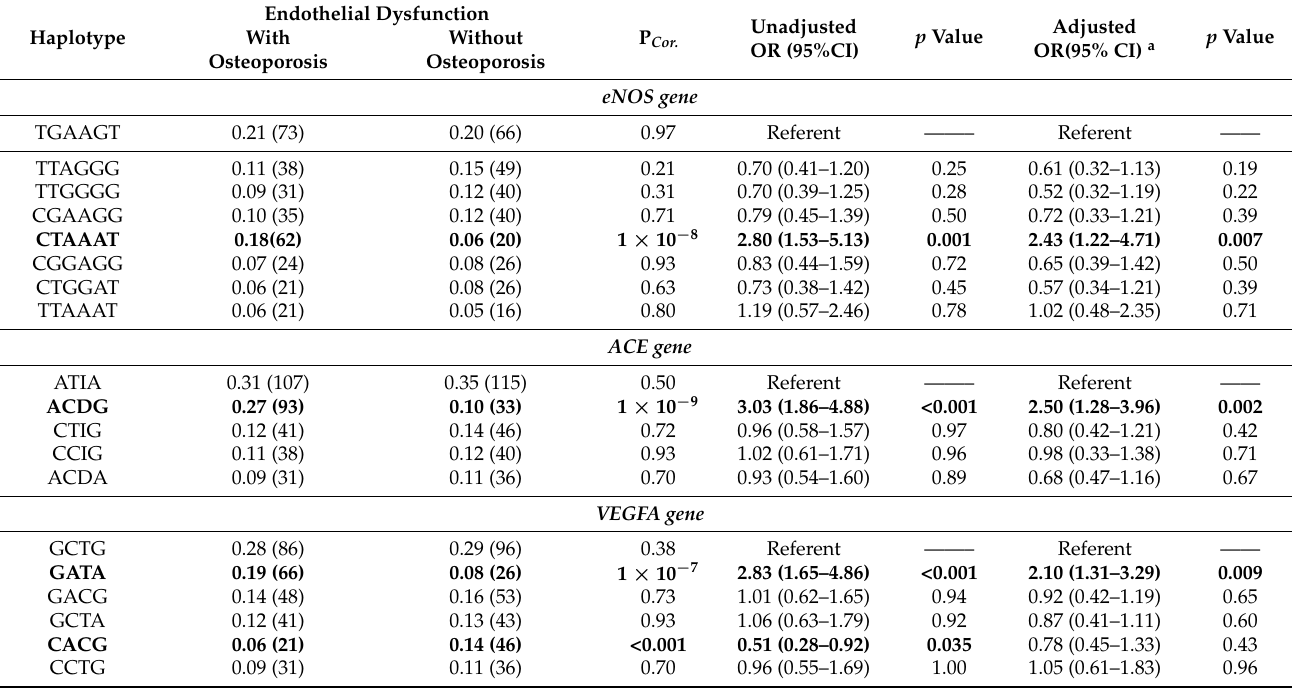
Table 7. Haplotypes within eNOS, ACE and VEGFA genes and their influence on osteoporosis risk.